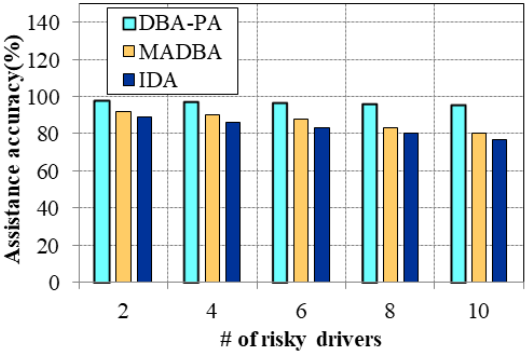
Figure 10. Number of Risky Drivers vs. Assistance Accuracy.